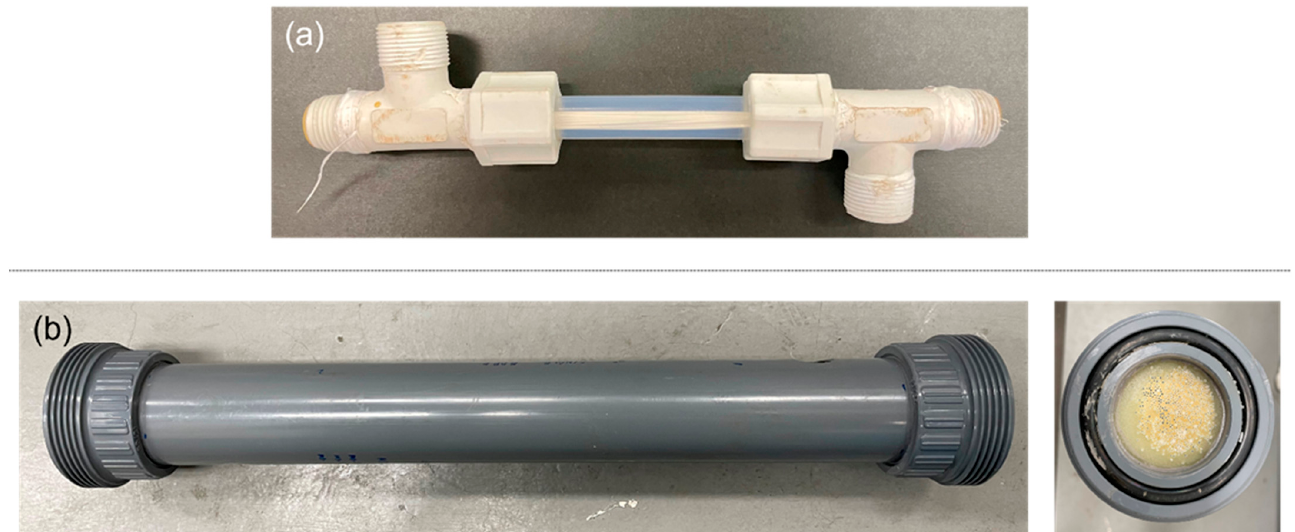
Figure 1. Scale-up of membrane distillation modules. ( a ) Lab-scale testing module (0.5-inch diameter); ( b ) pilot-scale testing module (2-inch diameter). Table 4. Characteristics of testing modules and operating conditions for vacuum membrane distilla- tion (VMD) of water from a NaCl solution. † Estimated